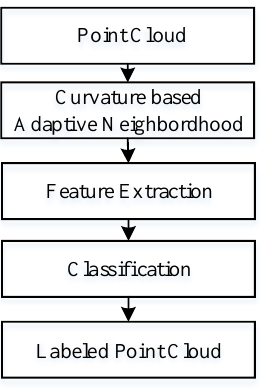
Figure 1. Flow chart of the proposed point cloud classification method.